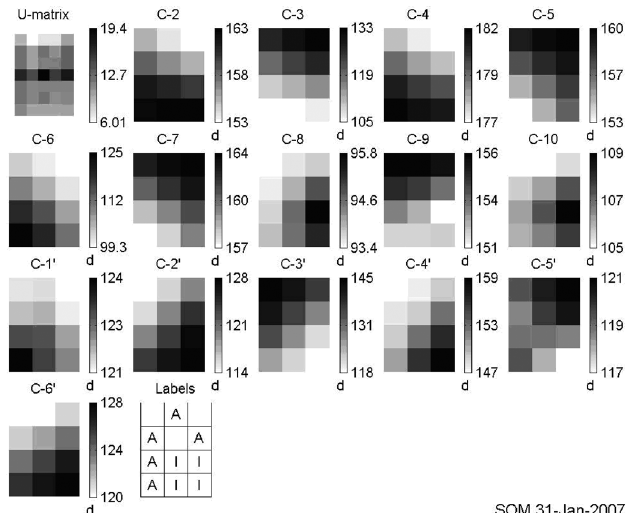
FIGURE 1 - Contribution of each carbon to the map based on its 13 C NMR data, showing the contribution of the chemical shifts of the C-3’ and C-4’ carbons, which can be identified and characterised with high hit of similarity for both regions on the map ( active and inactive compounds) supporting the relevance of these carbons to the antioxidant activity of